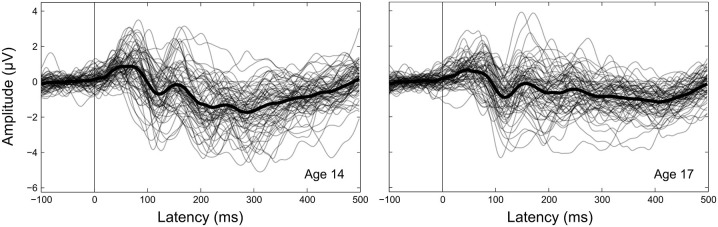
Between-participant CAEP variability. CAEPs are shown as individual waveforms for each participant at age 14 (left) and age 17 (right), averaged across the 15 electrodes in the frontocentral ROI. Individual participant CAEPs are plotted with partial transparency to visualize between-participant variability, with darker plot regions indicating lower variability. The grand average CAEP across all participants is shown as a thicker solid black line for each year.